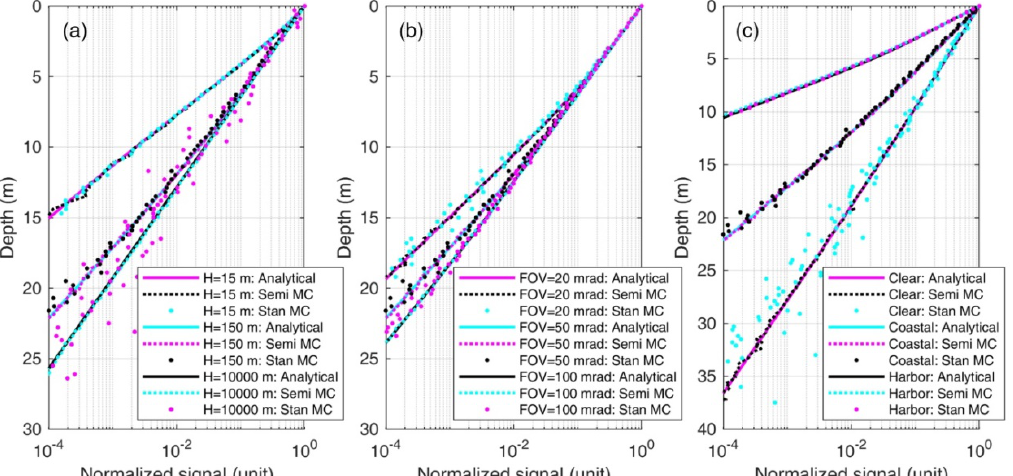
Fig. 2. Normalized lidar signals are calculated by the analytical model, semianalytic MC algorithm and standard MC algorithm at different: (a) heights; (b) FOVs; and (c) water